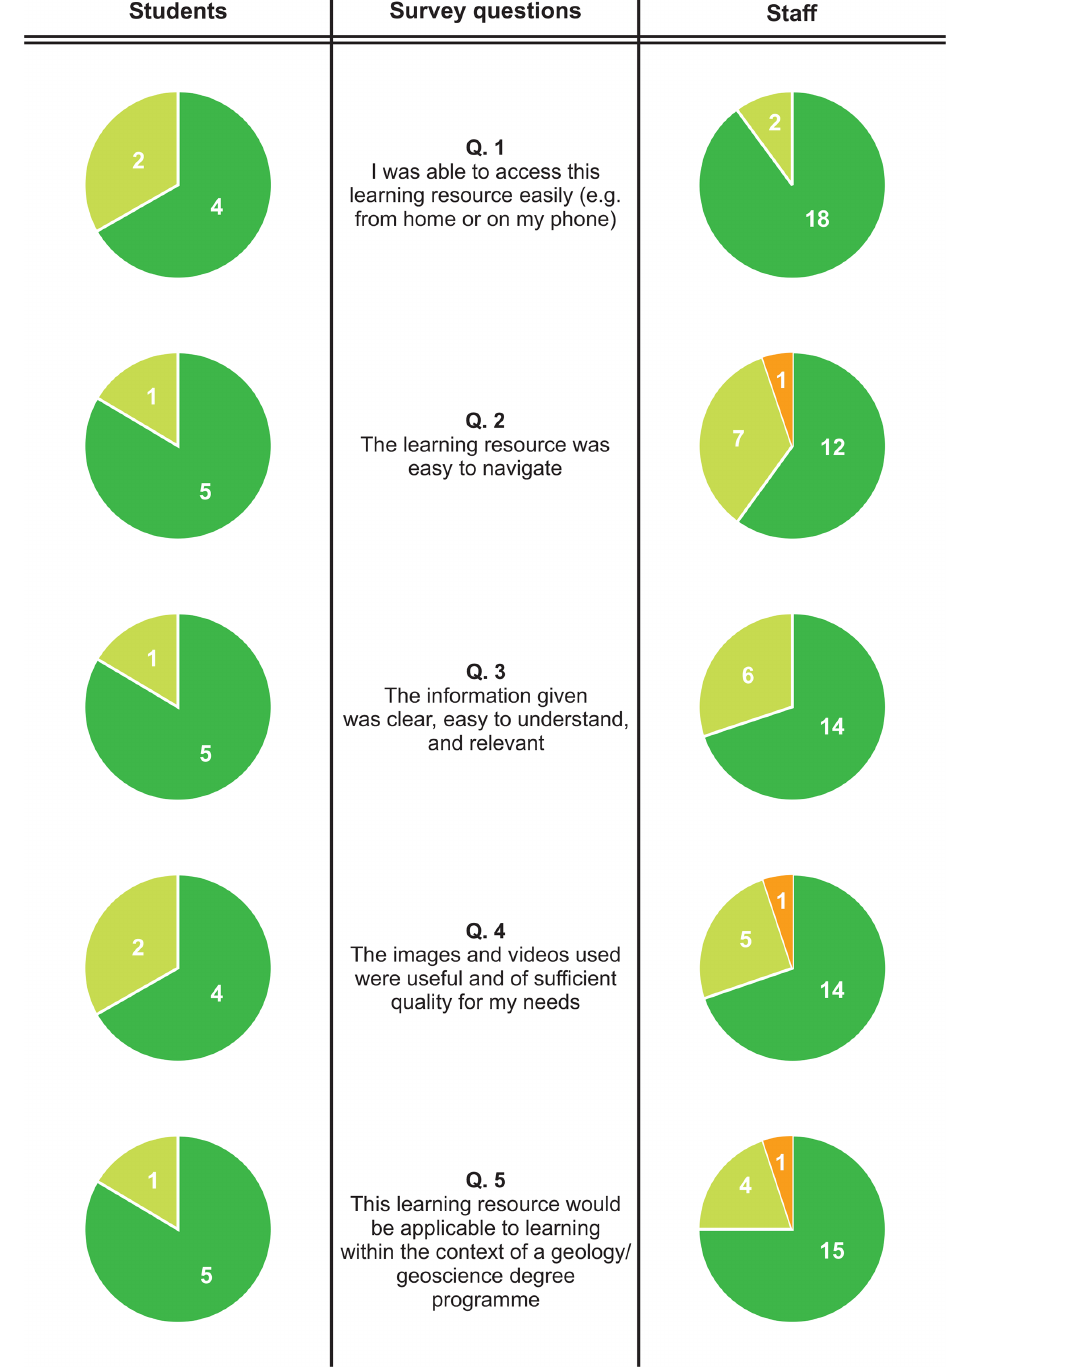
Figure 4. Summarized results of the survey feedback. The number of responses is marked on each section of the